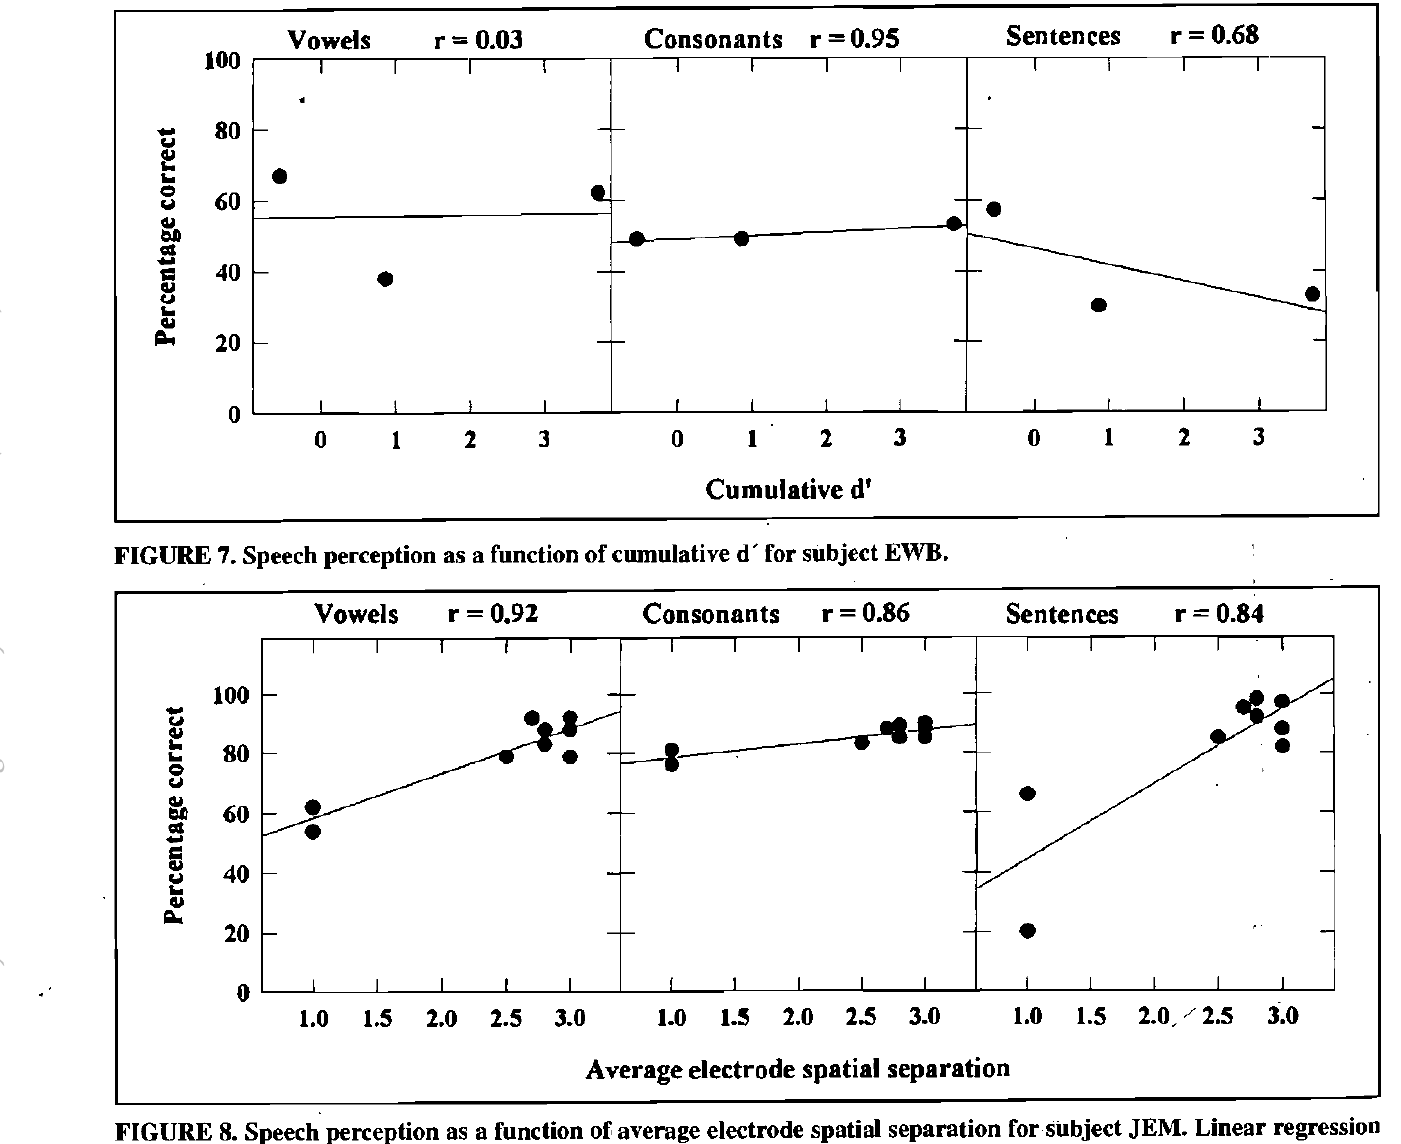
FIGURE 8. Speech perception as a function of average electrode spatial separation for subject JEM. Linear regression lines fitted through the data indicate correlation between electrode separation and speech perception performance. The correlation coefficients are given above each panel.